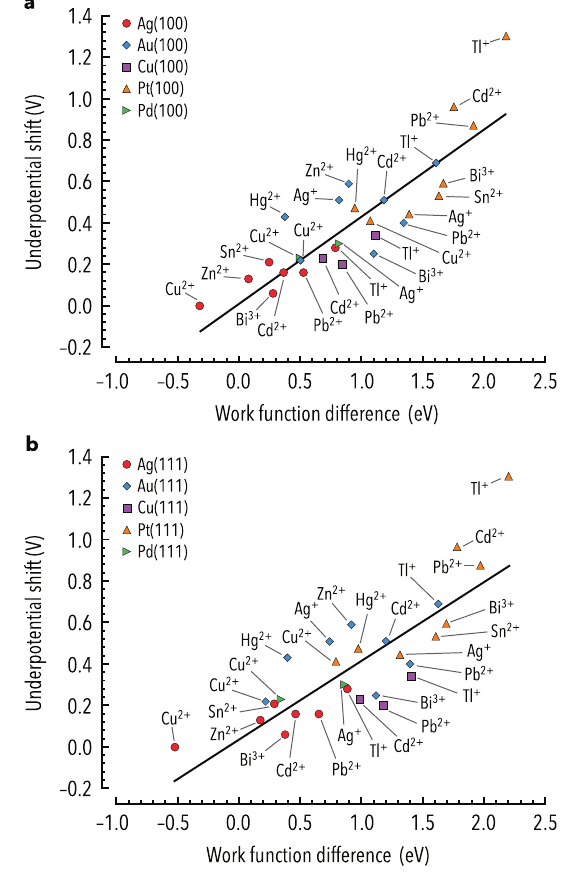
Fig. 1 Experimental underpotential shifts for polycrystalline electro- des against theoretical single crystal work function differences (see Supplementary Note 1 for calculation details) for a (100) and b (111) metal substrates. This correlation underscores the importance of the charge transfer that takes place between the adlayer and the substrate